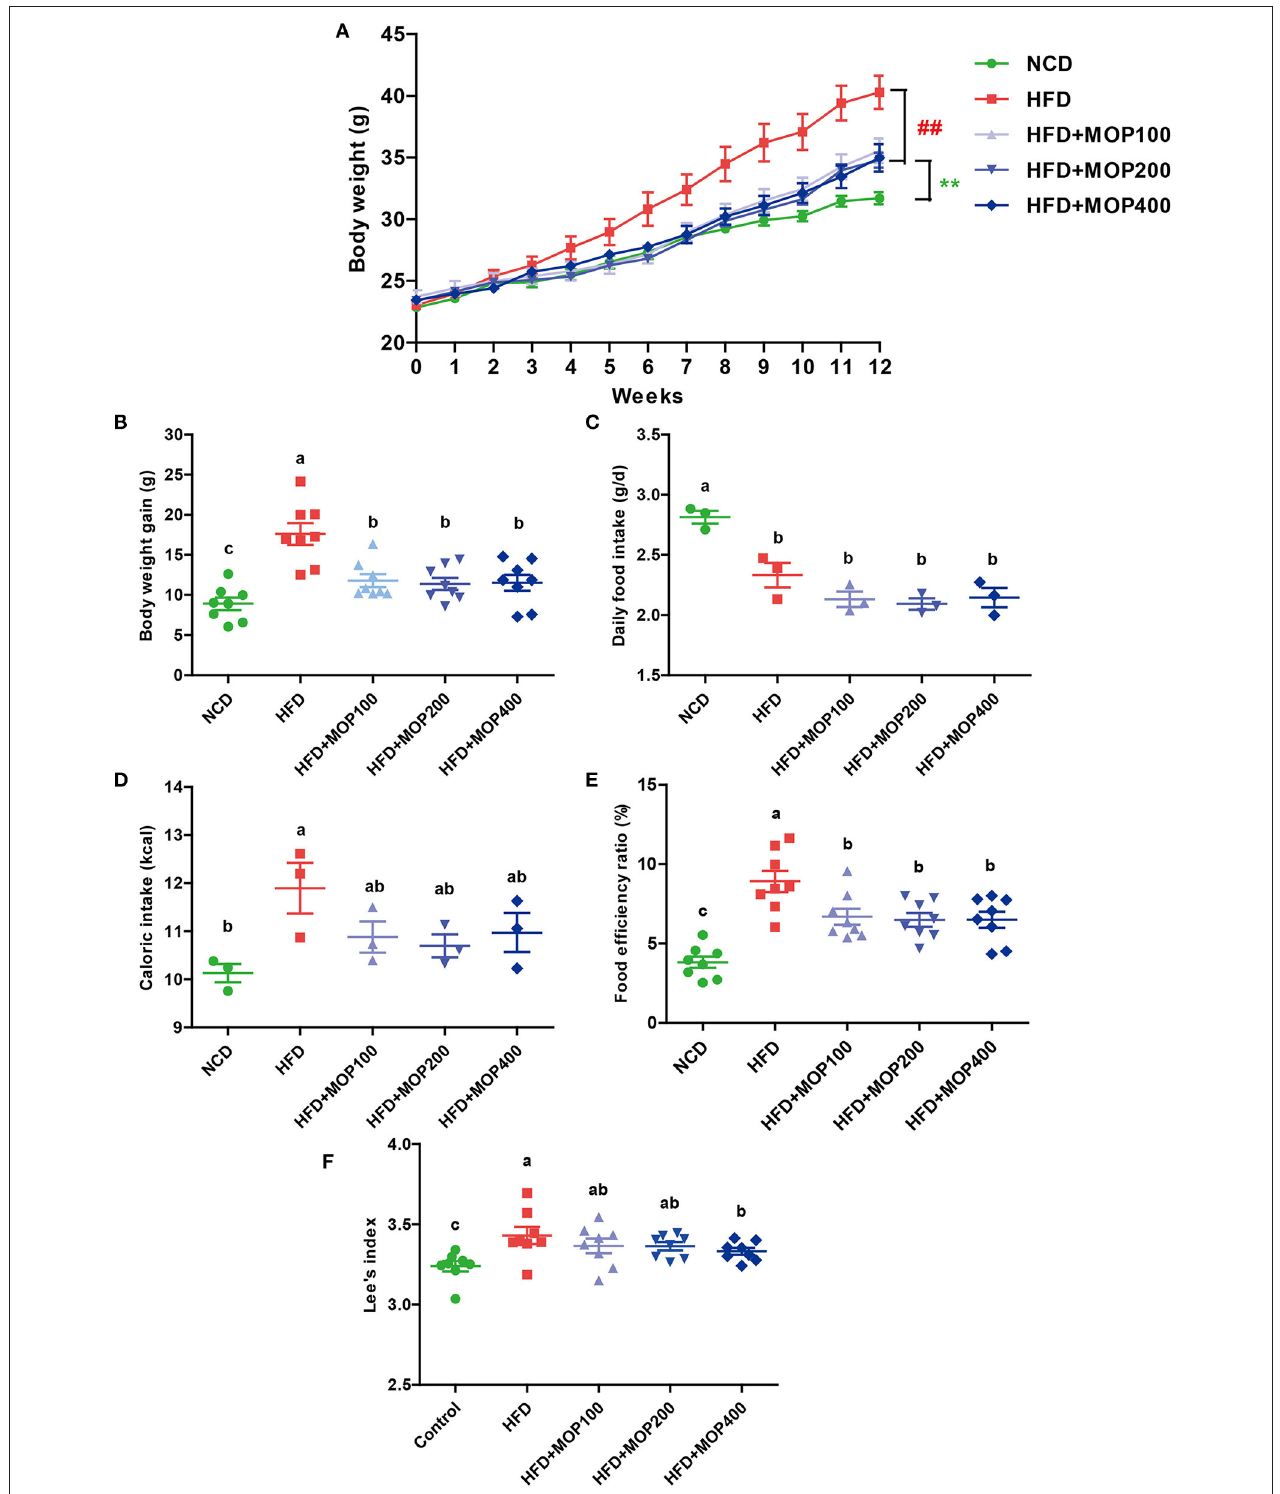
FIGURE 1 | MOP reduces body weight in HFD-fed mice. (A) The change in body weight of the mice during the experiment ( n = 8 mice/group); (B) body weight gain ( n = 8); (C) daily food intake ( n = 3 cages/group); (D) caloric intake ( n = 3); (E) food efficiency ratio (EFR), food efficiency ratio (%) = total body weight gain/total food intake × 100 ( n = 8); (F) Lee’s index, Lee’s index = body weight (g) ∧ (1 / 3) × 1,000/body length (cm) ( n = 8). Data are shown as means ± SEM. Bars marked with different superscript letters (a–c) indicate significant differences at p < 0.05 based on one-way ANOVA with Duncan’s post-hoc test.